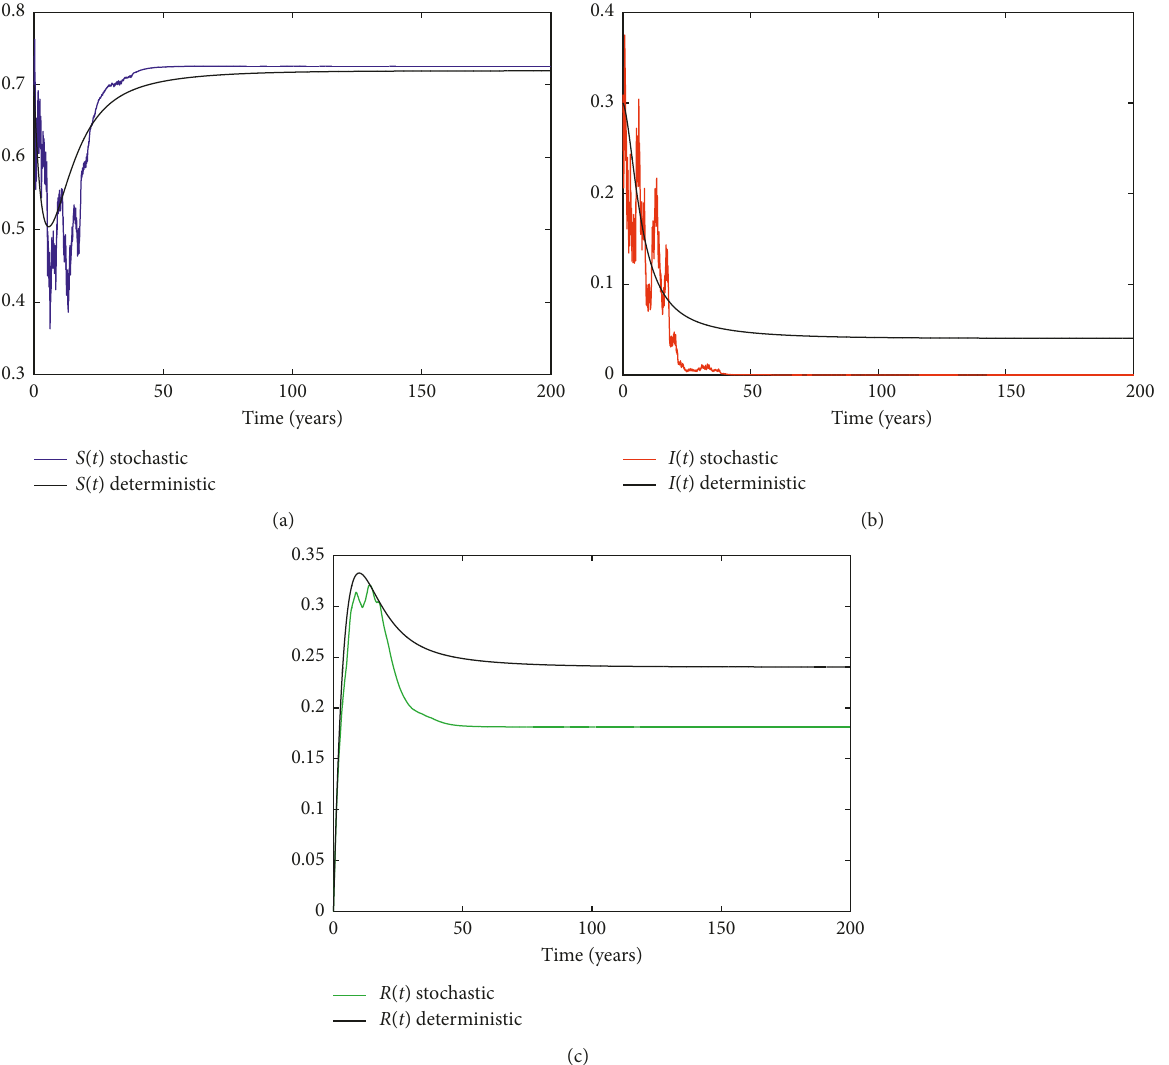
Figure 2: Simulations of the path (a) S ( t ), (b) I ( t ), and (c) R ( t ) for the deterministic system (1) and the corresponding stochastic system